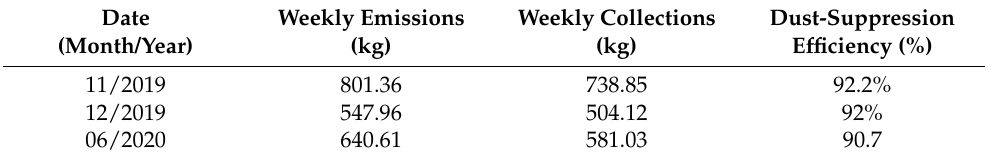
Table 5. The test results and the calculated dust-suppression efficiency over different time periods.